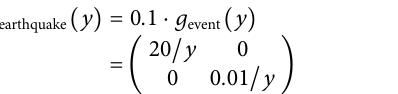
Frontiers in Earth Science |